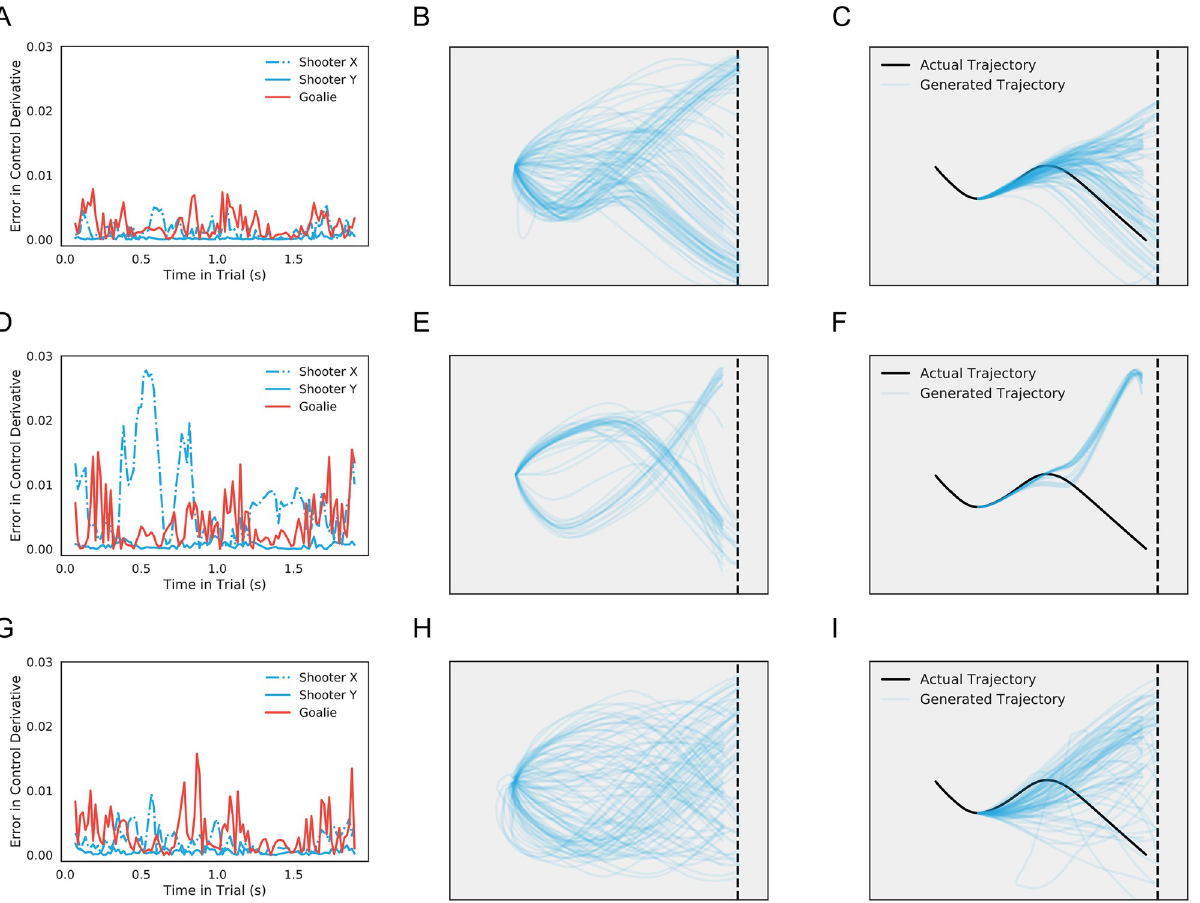
Fig 6. Model comparison. A: Difference between actual and predicted control derivatives for a trial (the one in Fig 4) in all three observed dimensions in the proposed model. B: Puck trajectories (n = 100) generated from the proposed model (only trials that last less than 25 trajectories (n = 100) by the proposed model from 7 figures based on the model with single Gaussian distribution. G, H, I: the same figures based on the linear model.